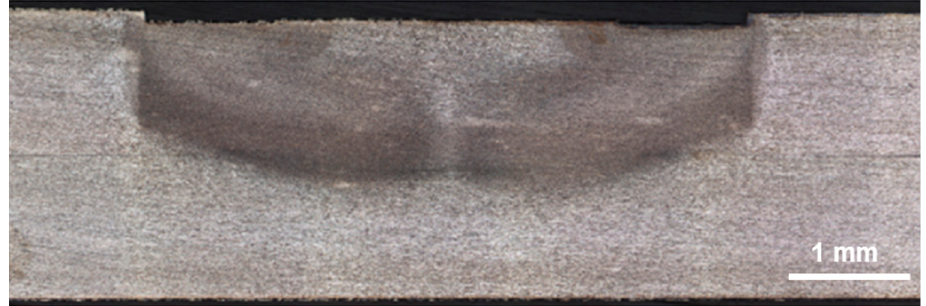
Figure 2. Cross-section image of a refill friction stir spot weld. The top and bottom sheets are bare 1.6 mm-thick AA7075-T6. The refill spot weld diameter is 7 mm.